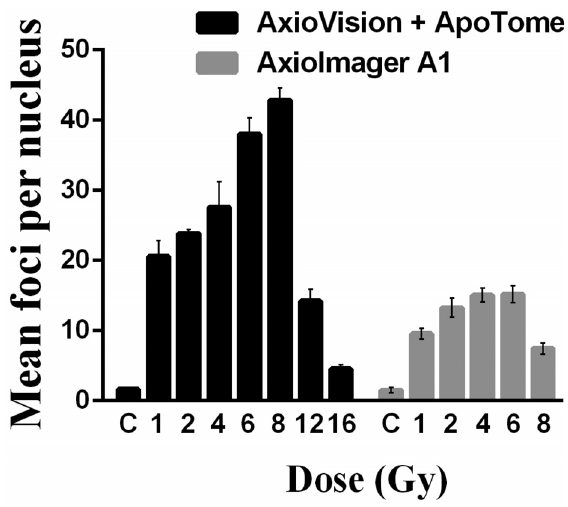
Figure 2 - Mean number of γ H2AX foci per HTB140 cell nucleus as a function of dose, 30 min after irradiation with γ -rays, measured by two types of microscopes: AxioVision comprising ApoTome software and AxioImager A1 (C-control). Data obtained from 3 experiments are presented as mean ± SEM.